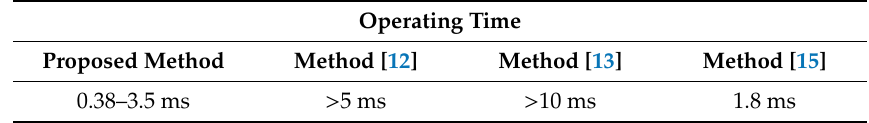
Table 3. The operating time of di ff erent methods.